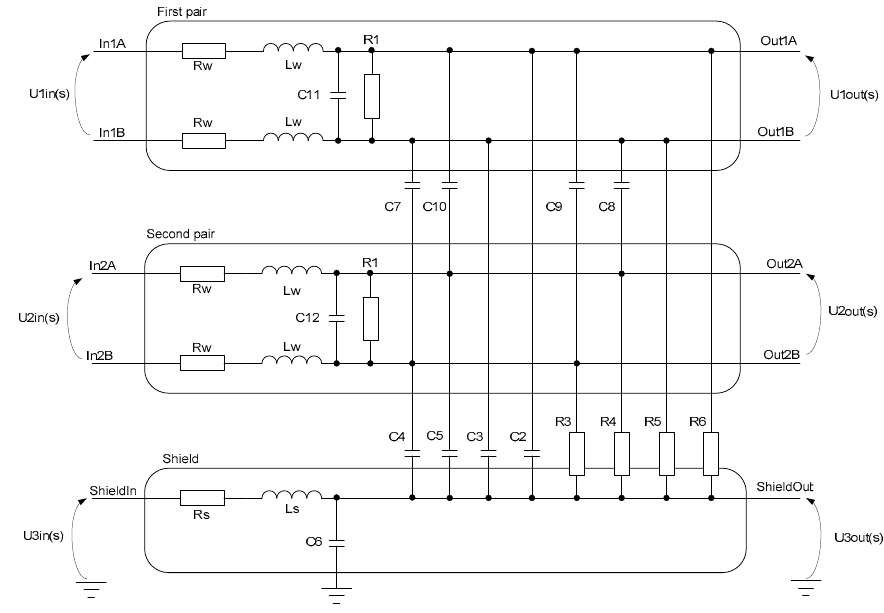
Figure 4. Model of the elementary part of a power and communication